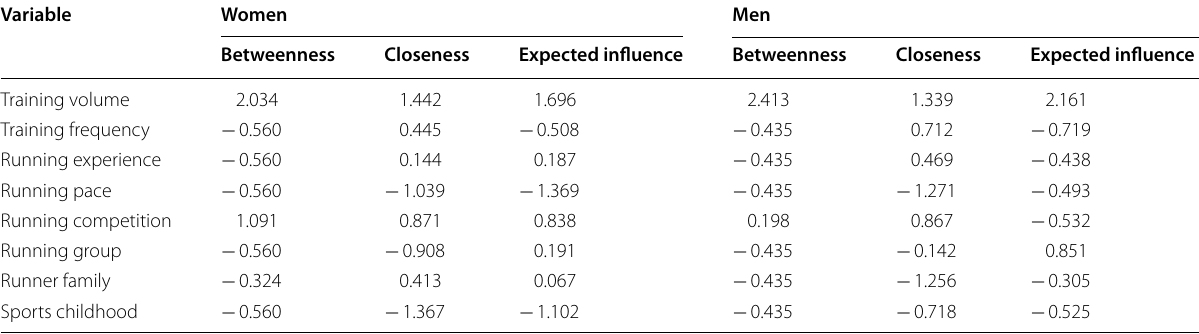
Table 2 Centrality indicators result for both sexes Variable Women Men Betweenness Closeness Expected influence Betweenness